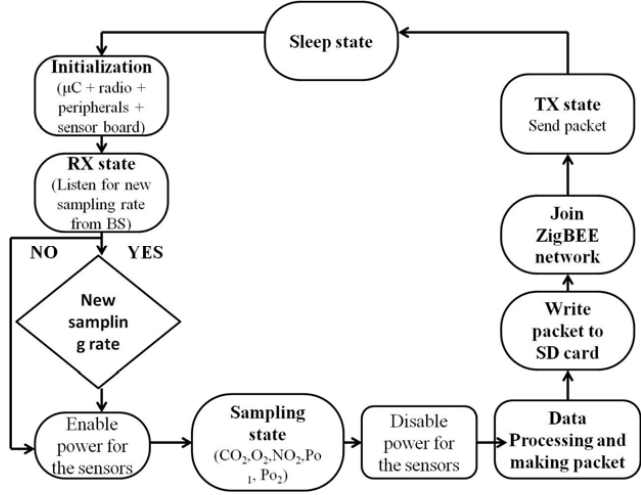
Figure 6. State machine for platform used in deployment (II).